Question: Summarize what this figure shows in one sentence.
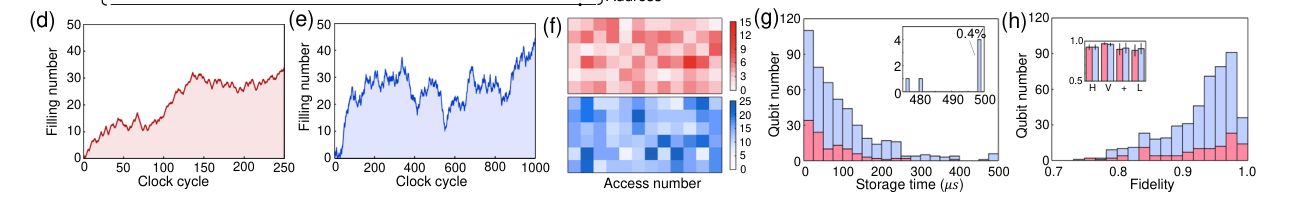
Answer: Random access quantum memory. (a) Snapshot of the RAQM with 72 qubit cells. (b) A random sequence of 500 µs. All the domains in each 2 µs operation are randomly generated including write-or-read (W/R), qubit cell index, and input polarization. (c) A similar random sequence of 1000 write or read operations with a length of 2 ms. We update the storage time of each stored qubit within a scrolling window of 500 µs, and execute forced read-out to the stored qubits about to expire in the next clock cycle. (d)-(h) The filling number of the memory, the total accesses in each qubit cell, the distribution of storage time of all output qubits, and the distribution of the state fidelities of all output qubits, for both 500 µs (red) and 2 ms (blue) cases. The inset in (g) shows the forced read-out happens at a chance of 0.4%. The inset in (h) demonstrates the corresponding fidelity for each input polarization. The error bars represent one standard deviation.